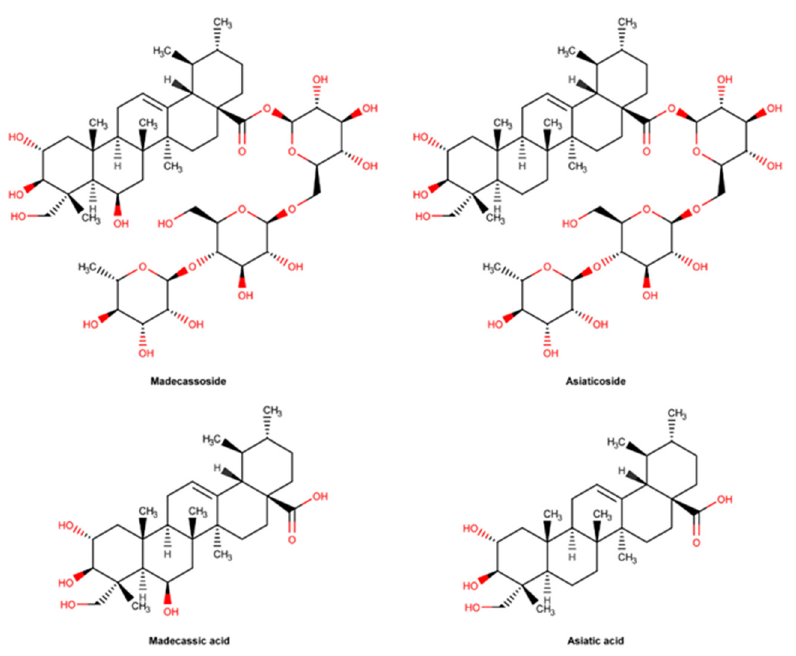
Figure 14. Chemical structure of madecassoside, asiaticoside, madecassic acid, and asiatic